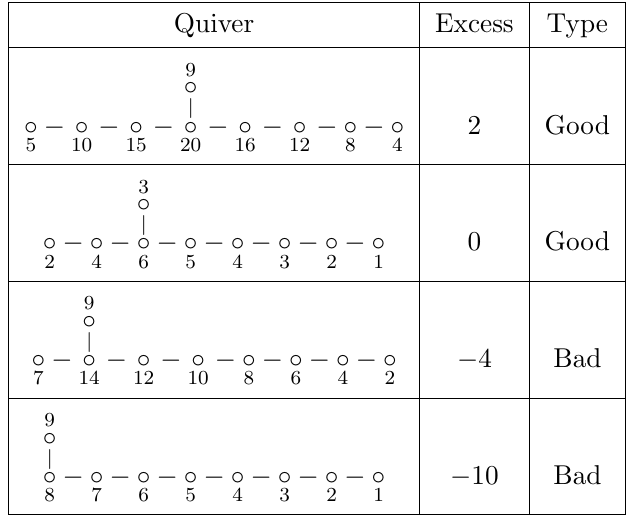
Table 1 . Quivers with a balanced A 8 subset and a single unbalanced node.